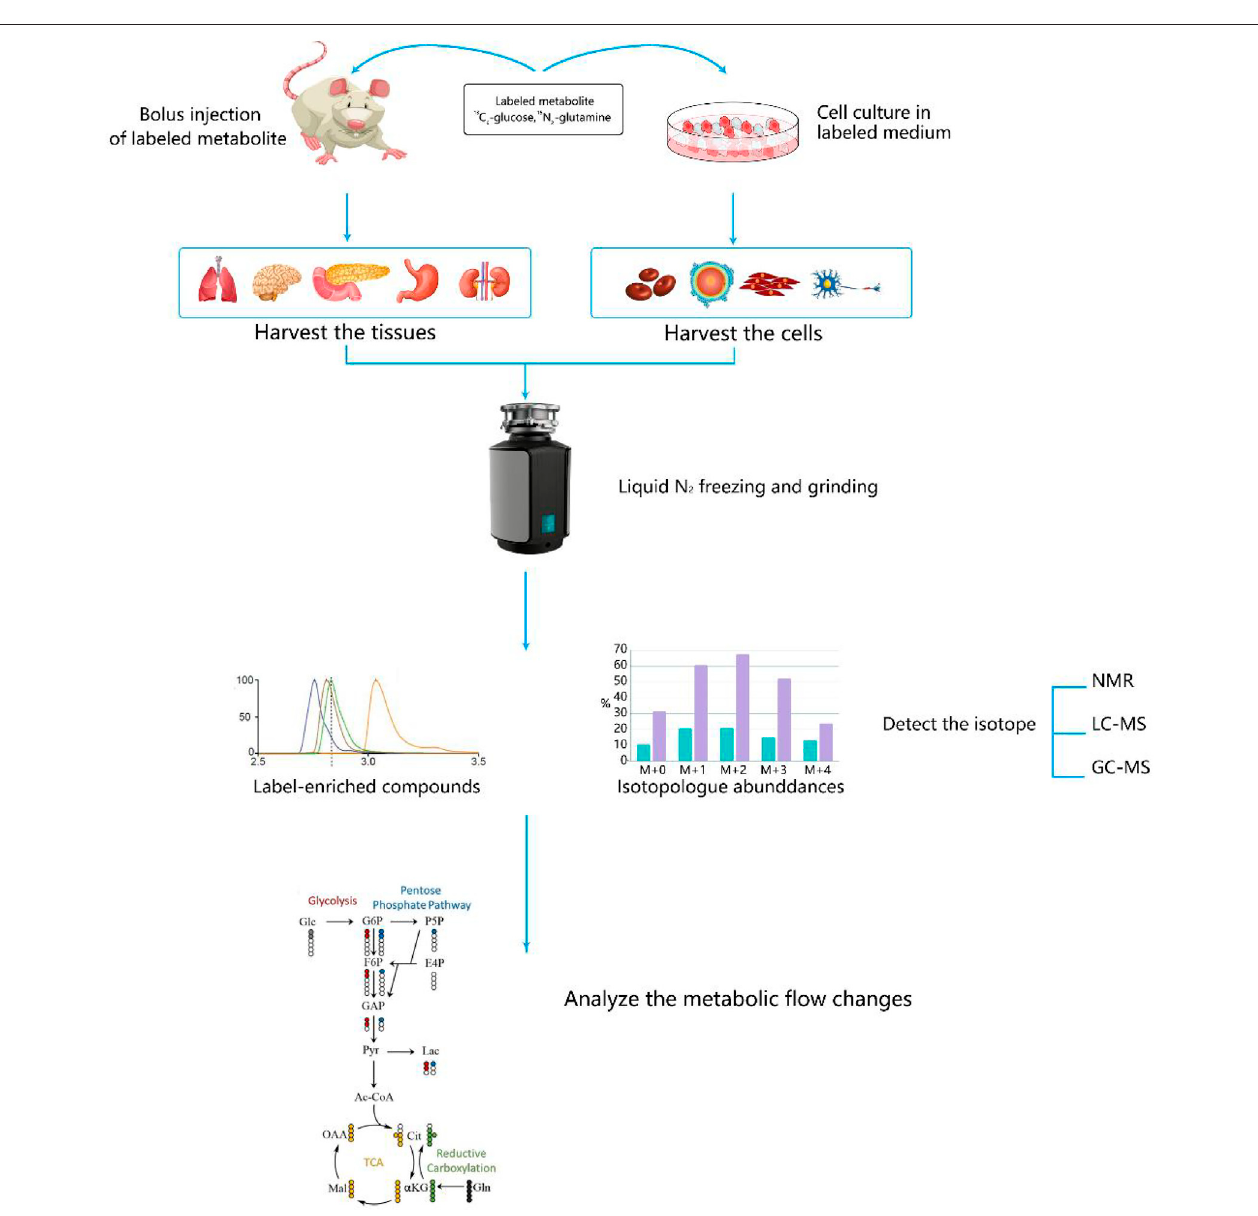
FIGURE 3 | Steps for studying cancer metabolism using stable isotope-resolved metabolomics (SIRM). Stable isotope tracers, such as uniformly 13 C-labeled glucose ( 13